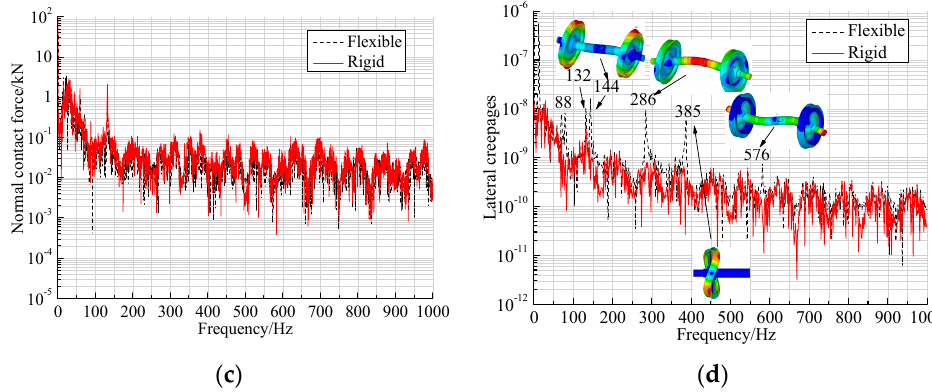
Figure 12. ( a ) Vertical irregularity; ( b ) Lateral irregularity; ( c ) Normal contact forces; ( d ) Lateral creepages.